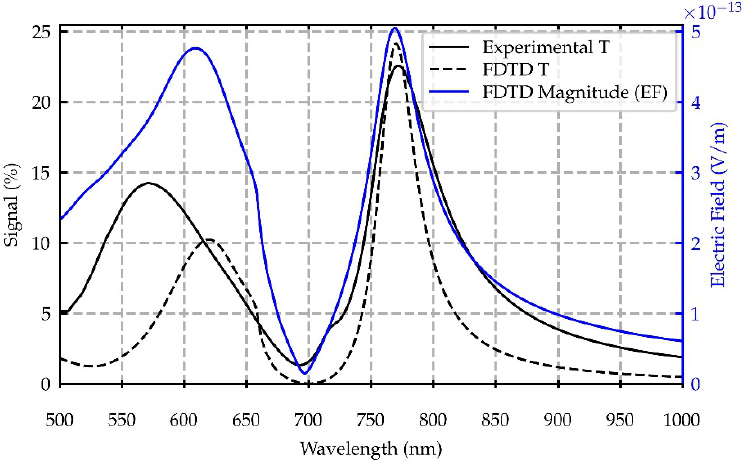
Figure 6. Comparison between experimental and simulated transmittance spectra at normal inci- dence, computed in the x–y horizontal plane placed at z = 530 nm together with the electric field magnitude evaluated in the x–y horizontal plane placed at z = 130 nm. Both z coordinates correspond to the gold/SiO 2 interface.